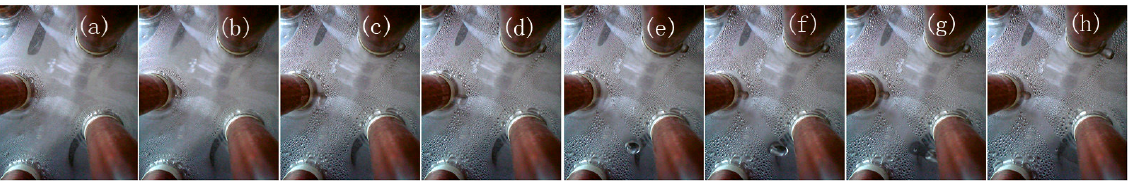
Figure 6. Condensate water on the surface of the aluminum fin with a hydrophilic layer: ( a ) τ = 10 s, ( b ) τ = 60 s, ( c ) τ = 120 s, ( d ) τ = 160 s, ( e ) τ = 200 s, ( f ) τ = 230 s, ( g ) τ = 260 s, ( h ) τ = 290 s. 3.2. The Effect of u a,in and RH in on the Geometry Form of Condensate Water on the Fin Surfaces Figure 7 shows the geometry form of condensate water on the fin surfaces of three different materials under different air inlet velocities ( u a,in ) at τ = 300 s, RH in = 50%, T a,in =